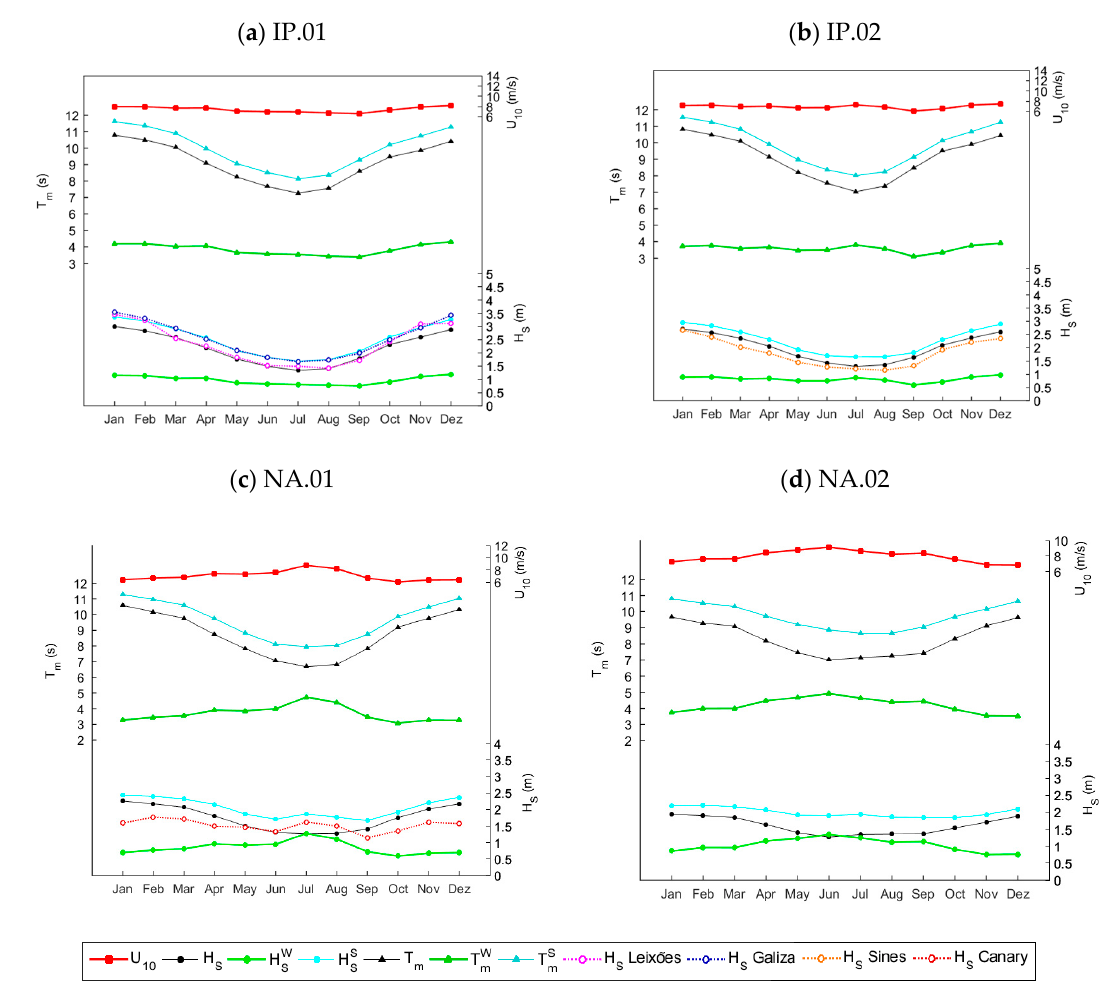
Figure 13. Intra-annual variability of U 10 (m · s − 1 ; red line with squares at upper right scale), T m , T s m and T ws m (s, black, blue and green lines with triangles, respectively, at central left scale), and H s , H s s and H w s (m, black, blue and green lines with dots, respectively, at bottom right scale), for key positions ( a ) IP.01, ( b ) IP.02, ( c ) NA.01, and ( d ) NA.02. The intra-annual variability of the H s (m) at buoys G and L (blue and magenta dashed lines with open circles) in panel ( a ), at buoy S (orange dashed line with open circles) panel ( b ) and at buoy G (red dashed line with open circles) panel ( c ).